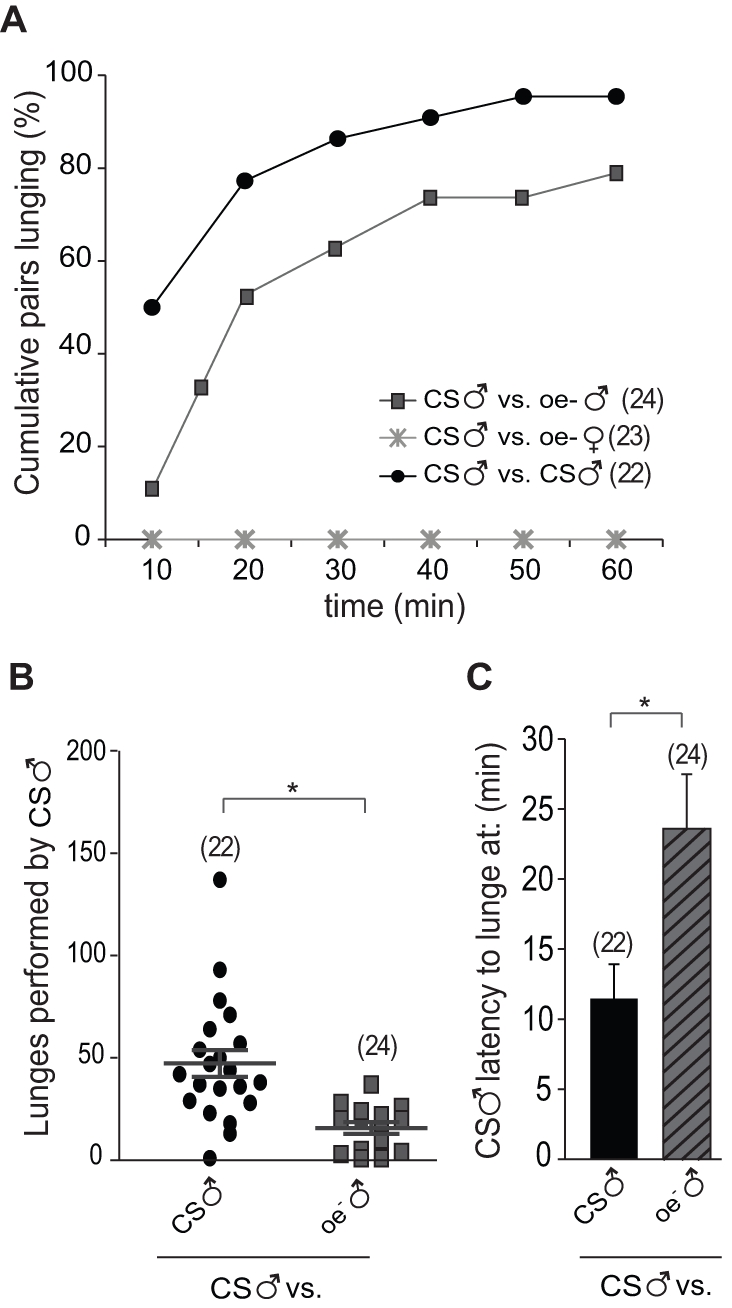
Control males do not attack oenocyte-less females.(A) Cumulative percentage of pairs that exhibit lunging in fights between CS males and an oenocytes-less (oe
−) male or female opponent. Aggression towards oe
− females was never observed. (B) Number of lunges performed by CS males towards another CS male or a oe
− male. Each dot represents the total number of lunges performed by one CS male during a fight (Mann-Whitney test; * p<0.05). (C) Latency of CS males to lunge at each category of opponent (Student's t test; * p<0.05). Error bars denote s.e.m.